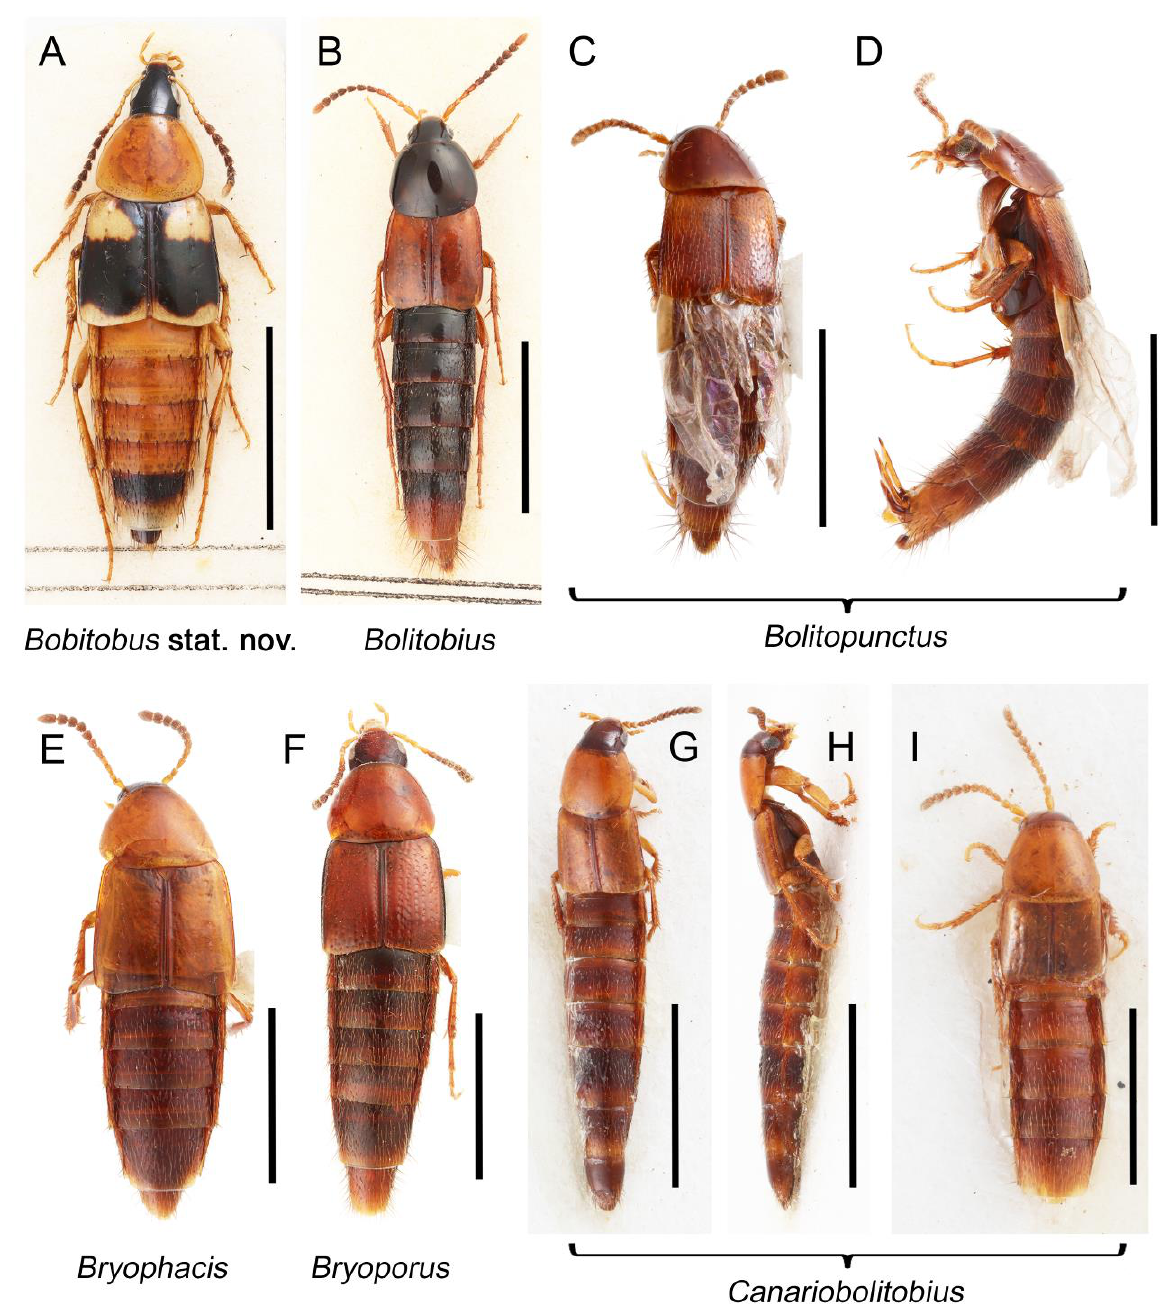
Figure 62. Habitus photographs of Mycetoporinae. ( A ) Bobitobus lunulatus (Linnaeus), dorsal view. ( B ) Bolitobius castaneus , dorsal view. ( C ) Bolitopunctus sp., dorsal view. ( D ) Bolitopunctus sp., lateral view. ( E ) Bryophacis smetanai Campbell, dorsal view. ( F ) Bryoporus rufescens LeConte, dorsal view. ( G ) Canariobolitobius filicornis (Wollaston) specimen 1, dorsal view. ( H ) Canariobolitobius filicornis specimen 1, lateral view. ( I ), Canariobolitobius filicornis specimen 2, dorsal view. Scale bars: 3.0 mm ( A , B ); 1.5 mm ( C – E , G , H ); 2.0 mm ( F ); 1.0 mm ( I